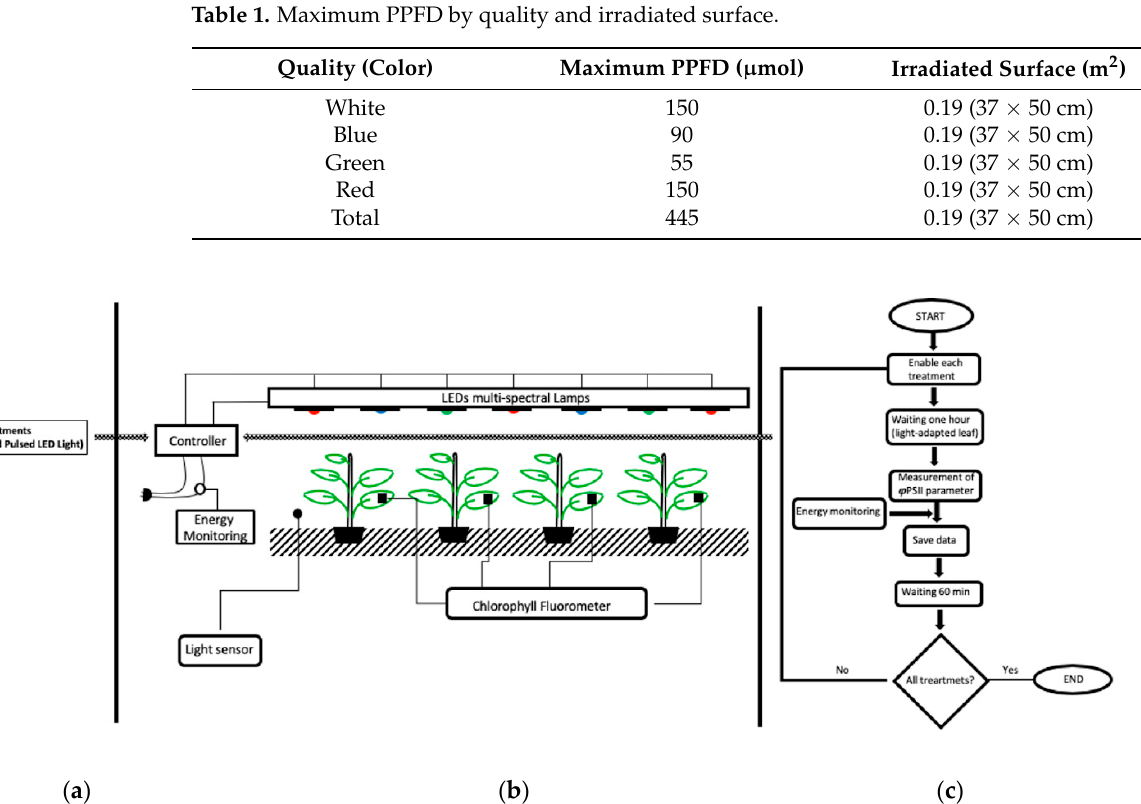
Figure 1. Experimental setup. ( a ) LED light treatments. ( b ) General scheme of the experiment. ( c ) Sequence of the meas ‐ urements.